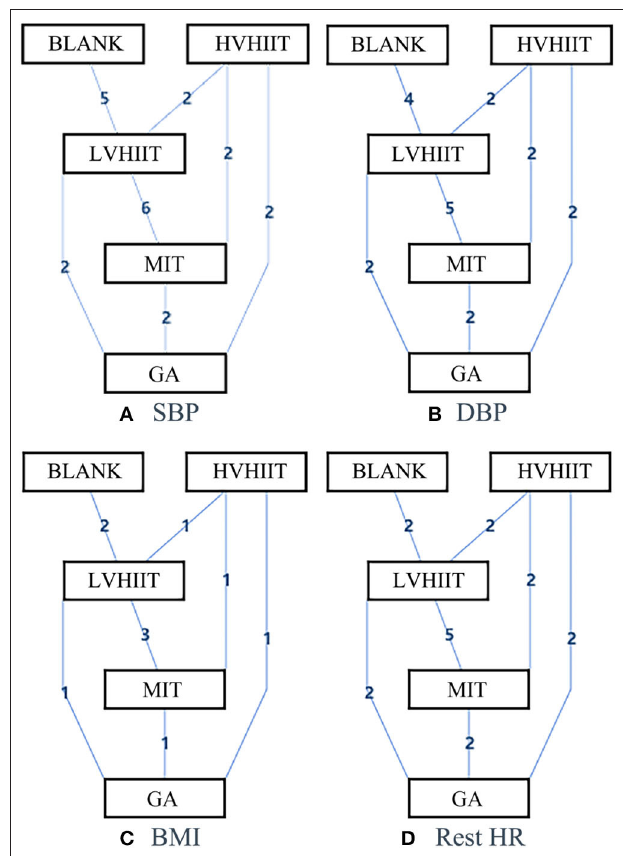
FIGURE 3 | The network structure of the intervention of systolic blood pressure (SBP), diastolic blood pressure (DBP), body mass index (BMI), and rest heart rate (HR). Blank, Blank control; LVHIIT, low-volume high-intensity interval training; HVHIIT, high-volume high-intensity interval training; MIT, Medium intensity training; GA, general physical